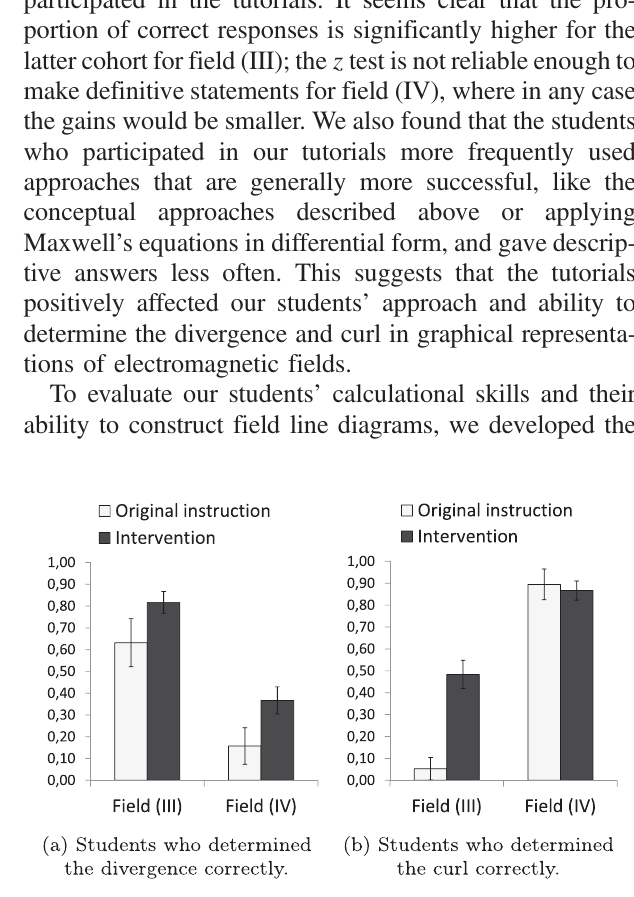
FIG. 10. The proportion of students who determined correctly where the divergence and curl are nonzero in a field vector plot of an electromagnetic field on the post-test (Fig. 9), after the original instruction ( N ¼ 19 ) and after the intervention ( N ¼ 57